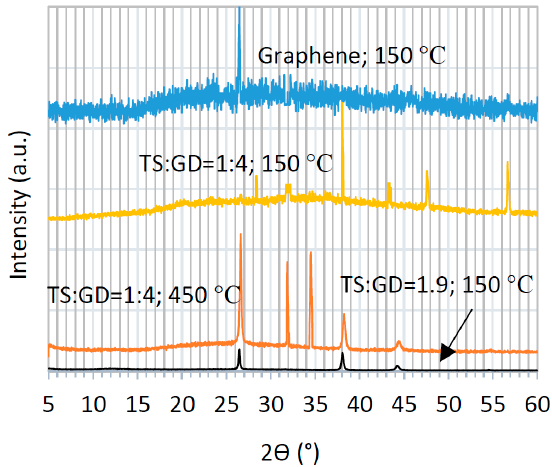
Figure 4. XRD patterns of graphene and graphene-TiO 2 thin films prepared at various compositions (TS:GD volume ratios) and annealing temperatures.